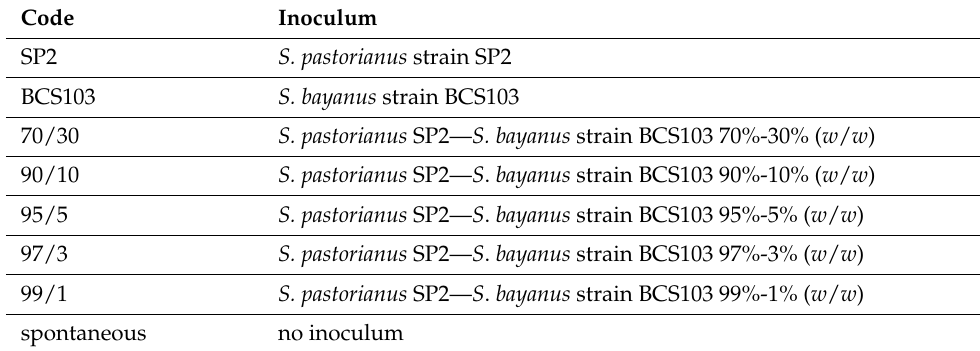
Table 1. Inoculation strategies employed in the present